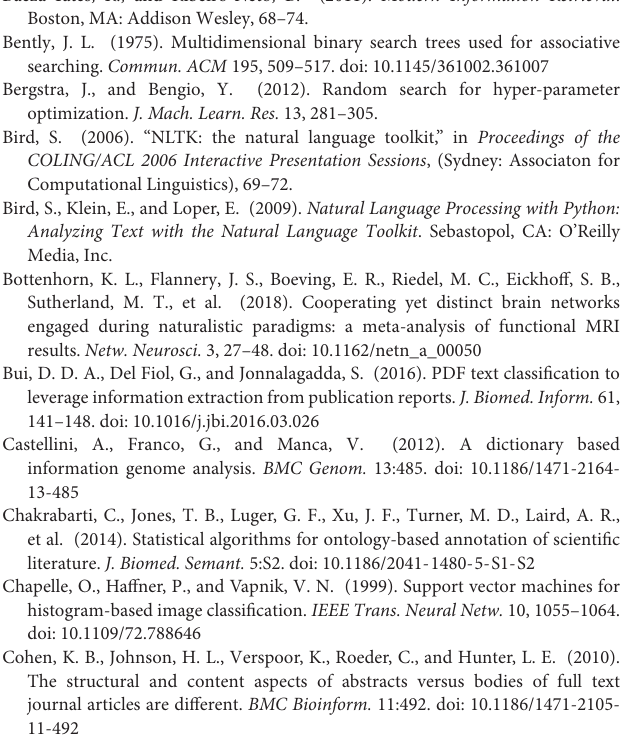
Figueroa, R. L., Zeng-Treitler, Q., Kandula, S., and Ngo, L. H. (2012). Predicting sample size required for classification performance. BMC Med. Inform.